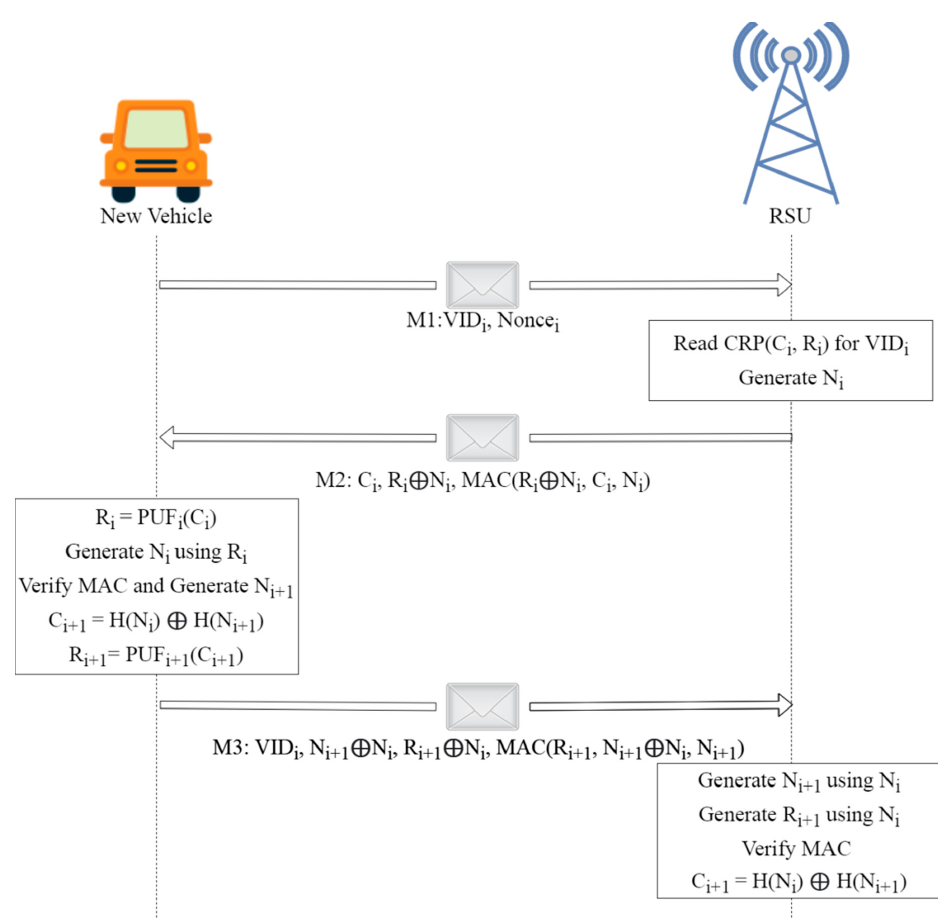
Figure 5. Authentication Using Physical Unclonable